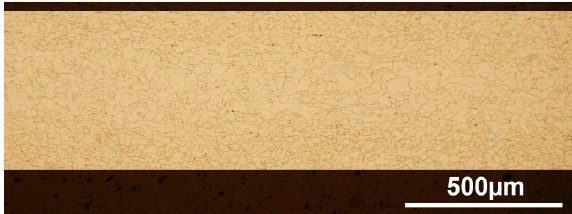
Figure 4. The initial microstructure of stator segment obtained from semi-finished non-oriented steel before heat treatment.